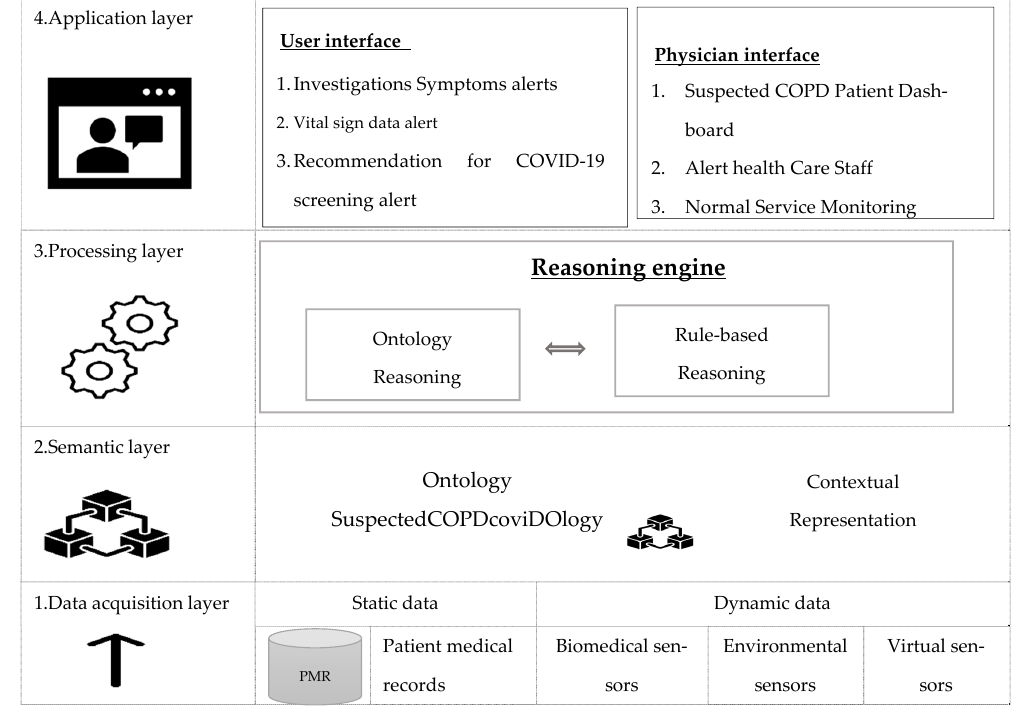
Figure 4. Architecture for COVID-19 suspected detection in the context of monitoring chronic obstructive pulmonary disease (COPD).